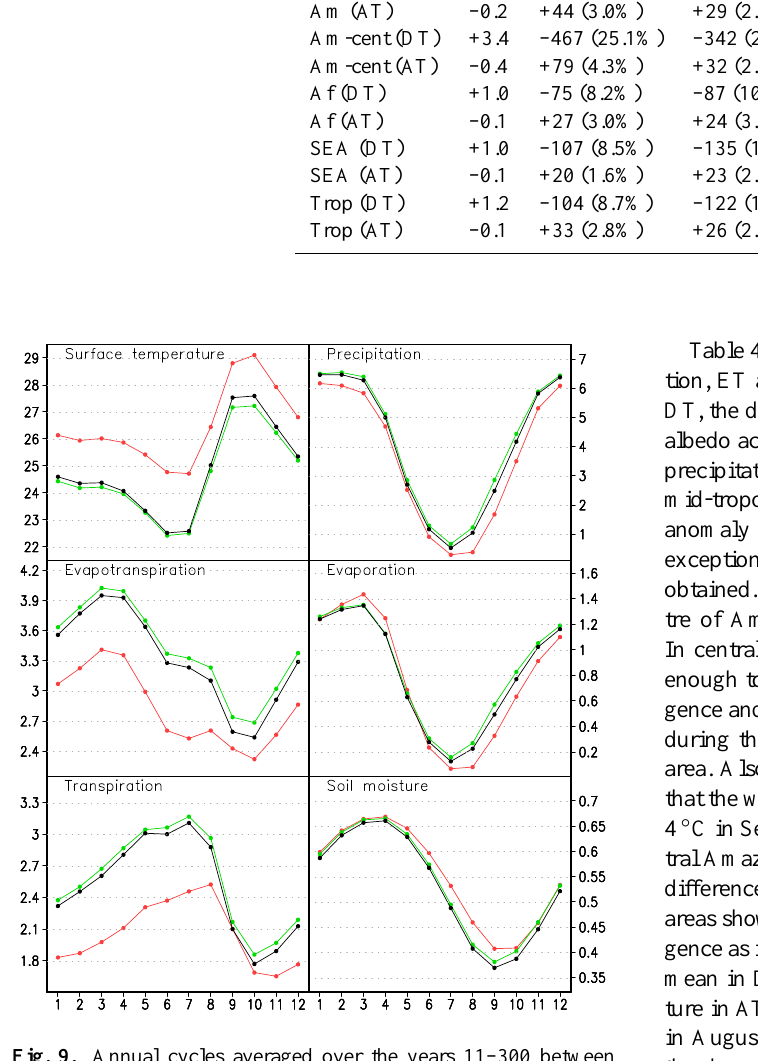
Fig. 9. Annual cycles averaged over the years 11–300 between 18.75 ◦ S and the equator in South America. Temperature is in ◦ C, soil moisture in m, all fluxes in mm/day. Black: control climate, red: tropical deforestation, green: tropical